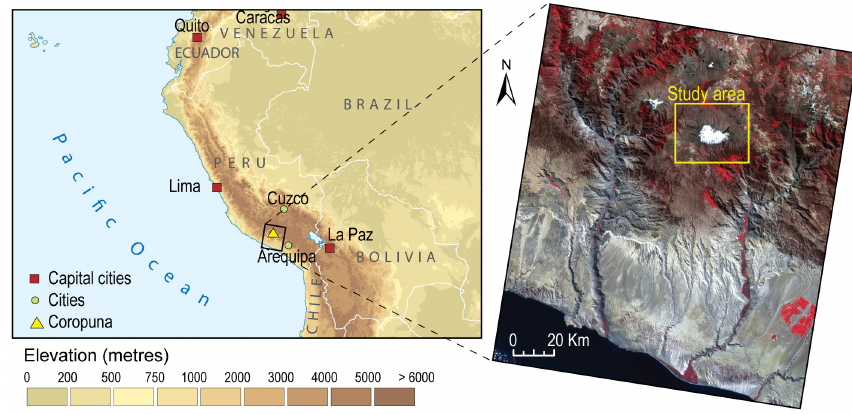
Fig. 1. Location map and study area with 2003 Landsat 7 satellite image (band 2, 3, 4).